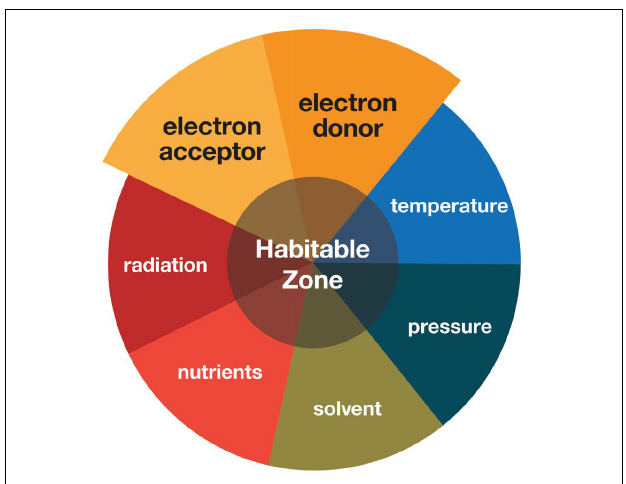
FIGURE 1 | Schematic illustrating the different parameters that contribute to habitability. This review primarily focuses on the electron donor and electron acceptor parameters on extraterrestrial targets and Earth’s low energy subsurface